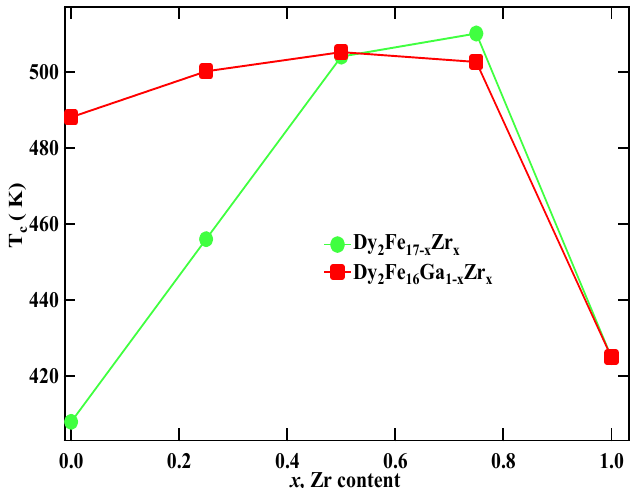
Figure 6. Comparative study for the Tc vs. x for Dy 2 Fe 17 − x Zr x and Dy 2 Fe 16 Ga 1 − x Zr x.